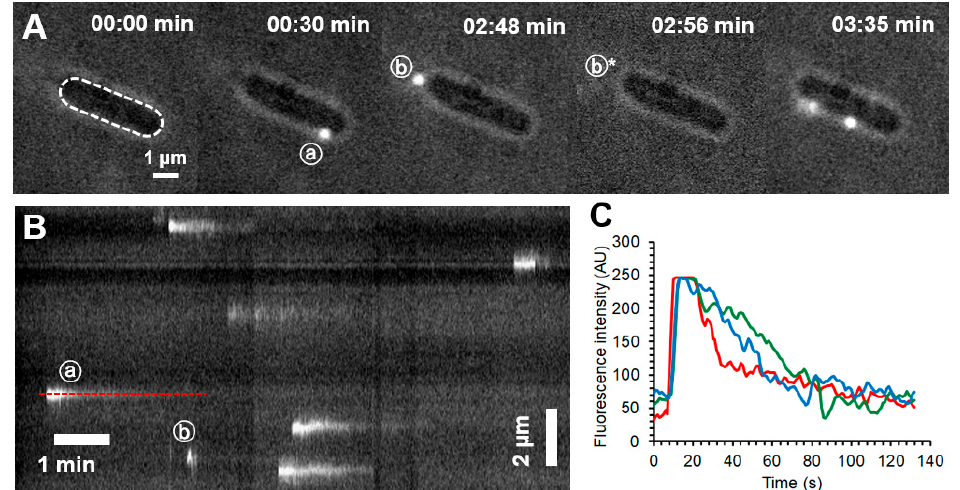
Figure 3. Single-phage infection process. ( A ) Snapshots of the early moments (0–10 min) of a single bacterium infection highlighting the docking of bacteriophages. The bacterial outline is slightly visible due to low levels of phase-contrast illumination. Dashed white line indicates the bacterial periphery along which a kymogram ( B ) was constructed. The same two phages are marked with circled ( a ) and ( b ) in the snapshots ( A ) and the kymogram ( B ). ( b* ) marks the position where phage ( b ) was visible 8 s earlier. Red dashed line marks the location of the relative intensity profile of a single phage ( a ) shown in ( C ) in red. Blue and green lines show the injection kinetics of two additional